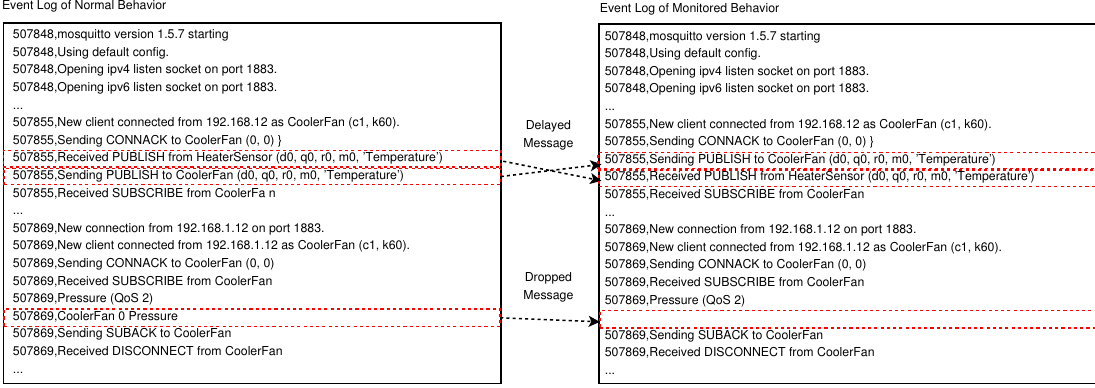
Figure 5. An illustration of message passing in the HVAC system.